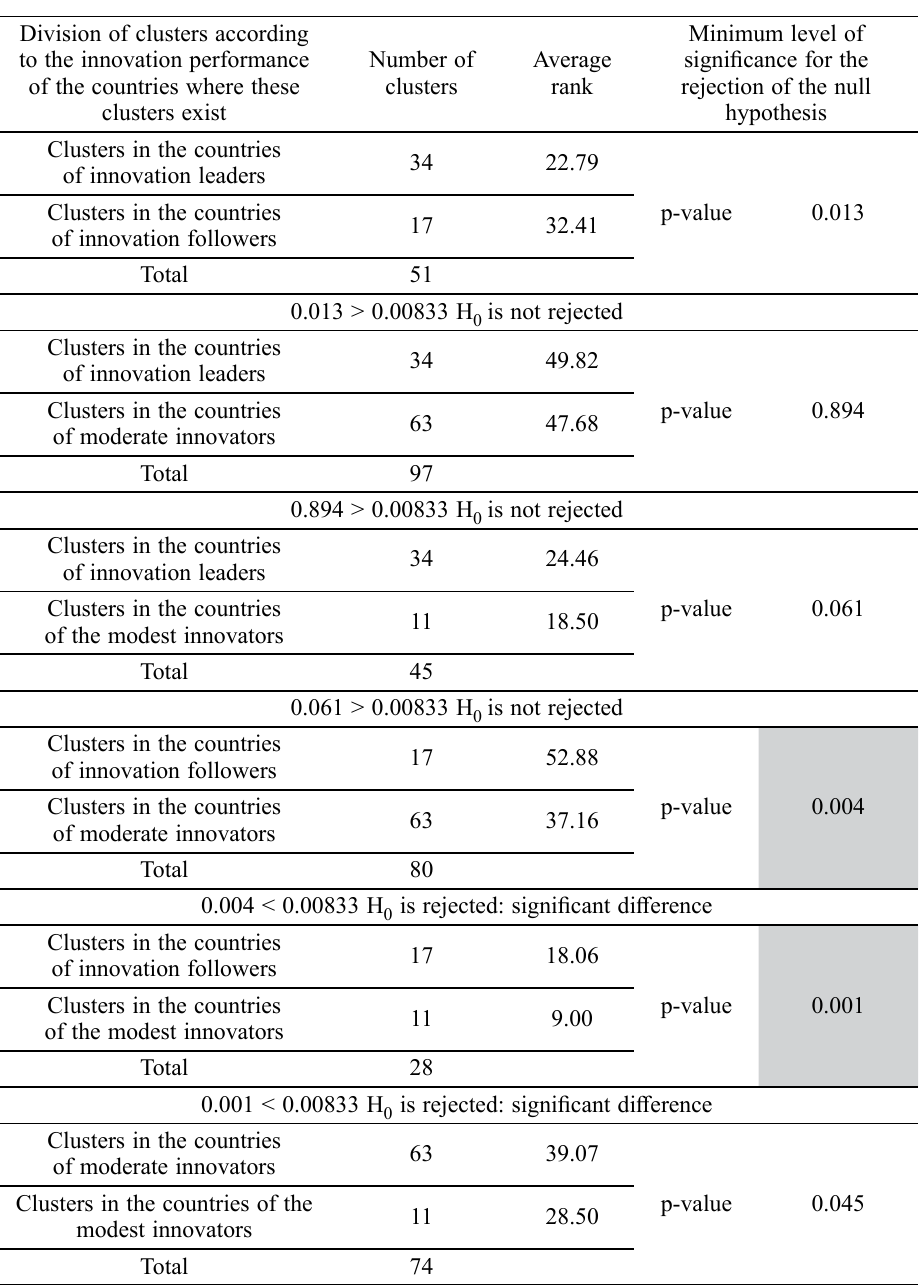
Table 3. Pair comparisons of shares of regional self-government subsidies in cluster budgets in various groups of